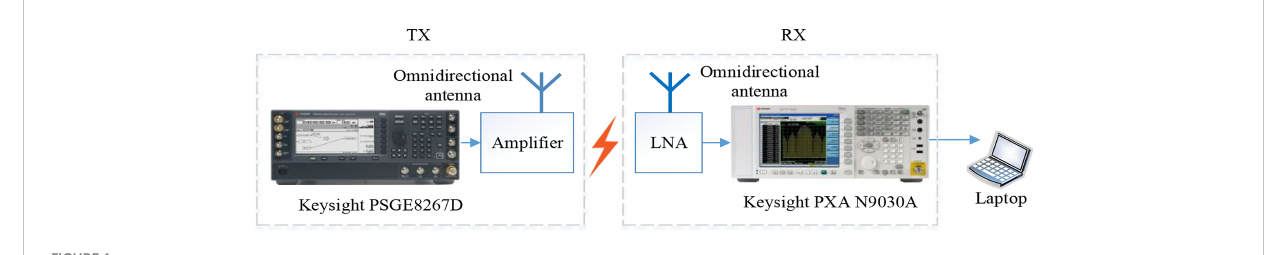
FIGURE 1 Overview of the equipment